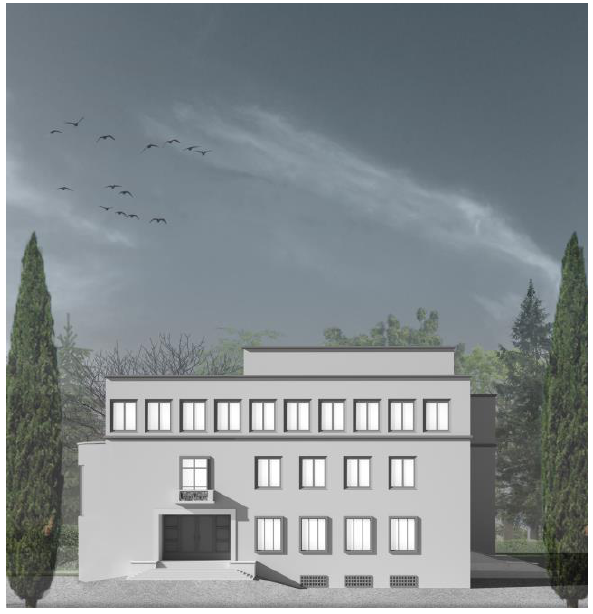
Figure 16. The Royal Park of Tirana. Render of the Villa